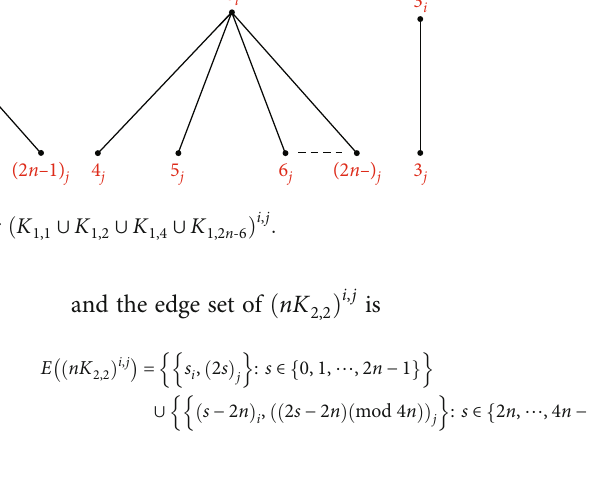
1, n − 2 ÞÞ i , j 2 ð